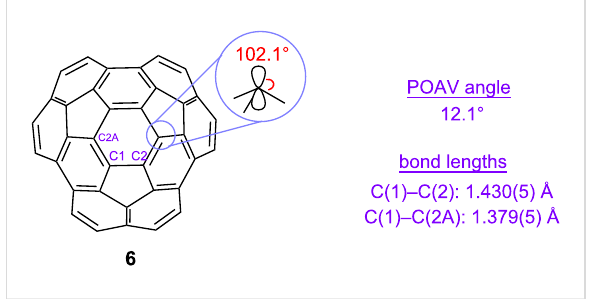
Figure 5: POAV angle and bond lengths of circumtrindene.